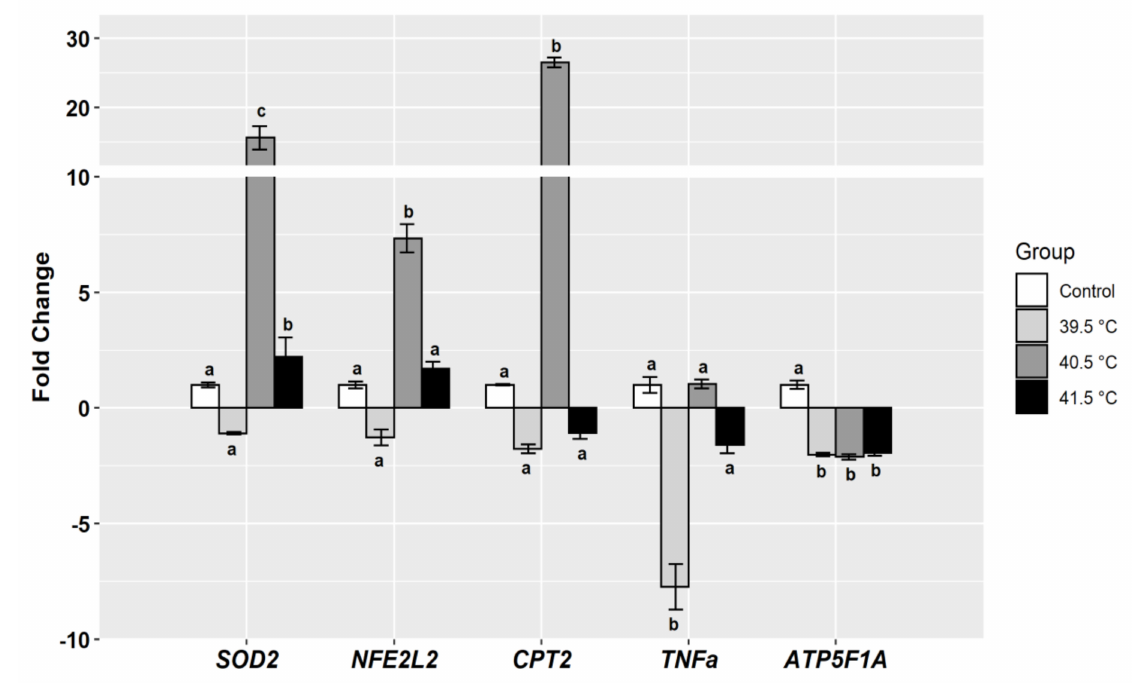
Figure 3. Fold change of some targeted genes post-heat treatment of buffalo granulosa cells (39.5 ◦ C, 40.5 ◦ C, or 41.5 ◦ C for the last 24 h of culture, 7 days) in comparison to control group (37 ◦ C); GAPDH was used to normalize the abundances of mRNA transcripts for targets genes; Data are presented as mean ± SEM; bars with different letters indicate significant differences ( p < 0.05); and data from three biological